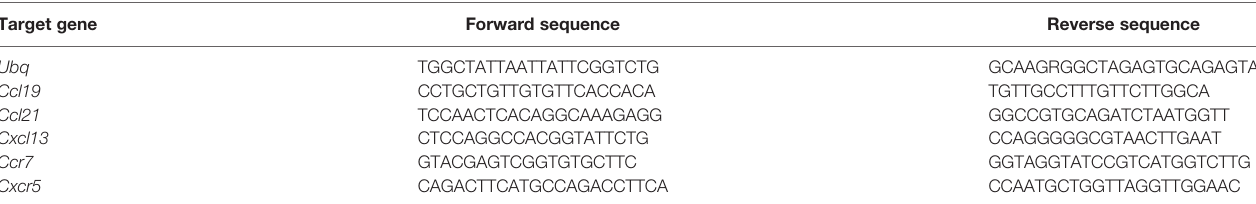
TABLE 1 | Primers used to determine gene expression by RT-PCR. Target gene Forward